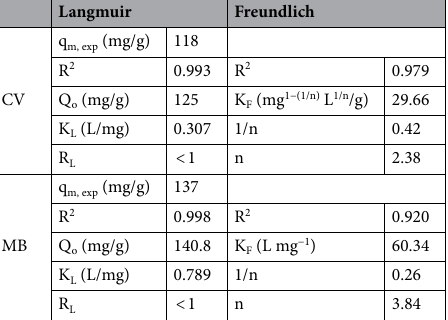
Table 2. Langmuir and Freundlich isotherm factors for MB&CV-removal onto MMT-mAmCs under the optimum removal